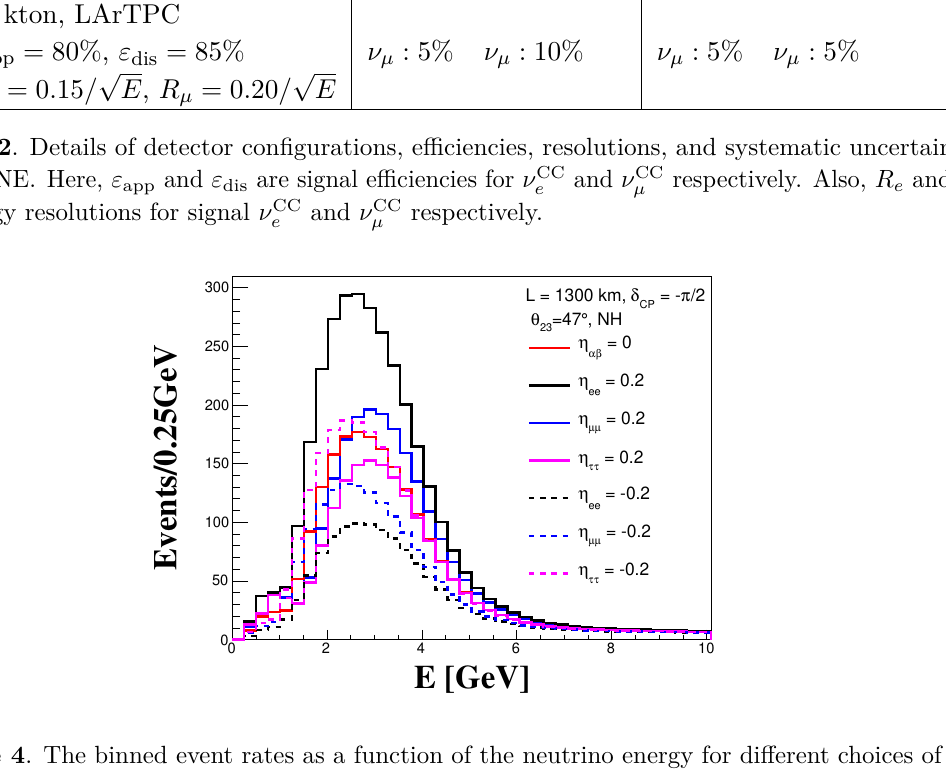
Figure 4 . The binned event rates as a function of the neutrino energy for different choices of η αβ . The results shown here are for δ CP = − π /2, θ 23 = 47 ◦ and